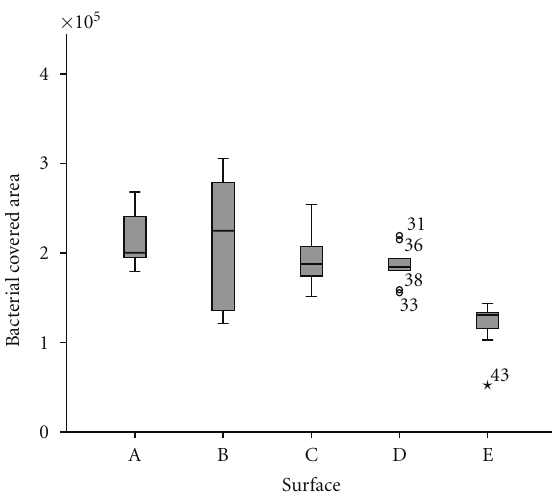
Figure 11: Quantification of bacterial adhesion ( Streptococcus sanguinis ) on glass coated with nonhexylated polymer (A), glass coated with hexylated polymer (B), glass coated with hexylated polymer and spin coated with amorphous silicon dioxide (C1 = middle; C2 = border), glass coated with hexylated polymer and spin coated with nanoporous silicon dioxide (D), and untreated glass (E); significant di ff erences ( P ≤ 0 . 05) found between all surface modifications and untreated glass (Sche ff ´e